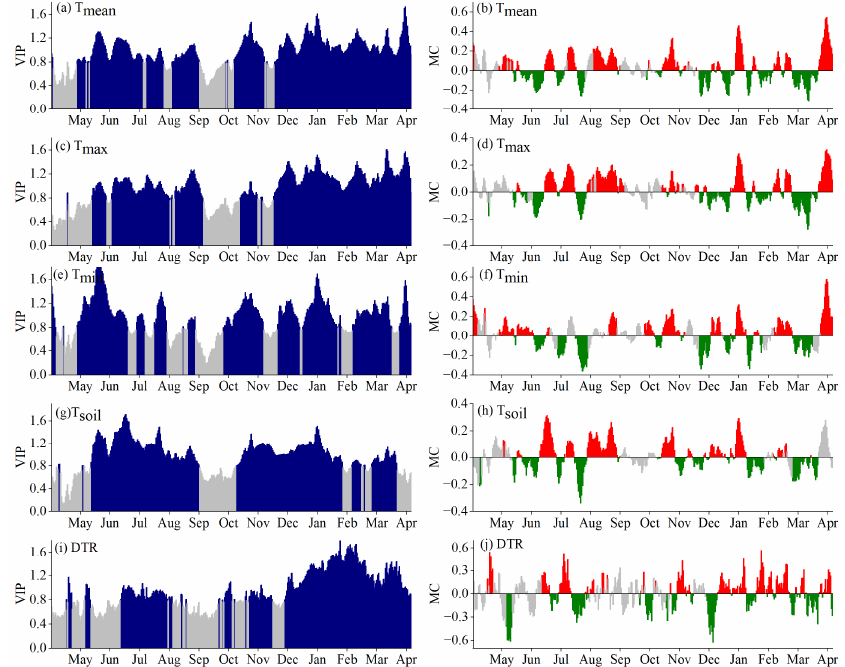
Figure 2. Results of partial least squares (PLS) regression correlating the start of the growing season (SOS) from 1985–2018 with 31-day running means of climatic factors. ( a , b ) Daily mean air temperature (T mean ), ( c , d ) daily maximum air temperature (T max ), ( e , f ) daily minimum air temperature (T min ), ( g , h ) daily soil surface temperature (T soil ) and ( i , j ) diurnal temperature range (DTR) from the previous May to April of the year. ( a , c , e , g , i ) indicate the variable importance in projection (VIP): blue indicates VIP ≥ 0.8, grey indicates VIP < 0.8; ( b , d , f , h , j ) indicate the standardized model coefficients (MC): red indicates a positive model coefficient, green indicates a negative model coefficient, and grey indicates an insignificant model coefficient. Same as below.